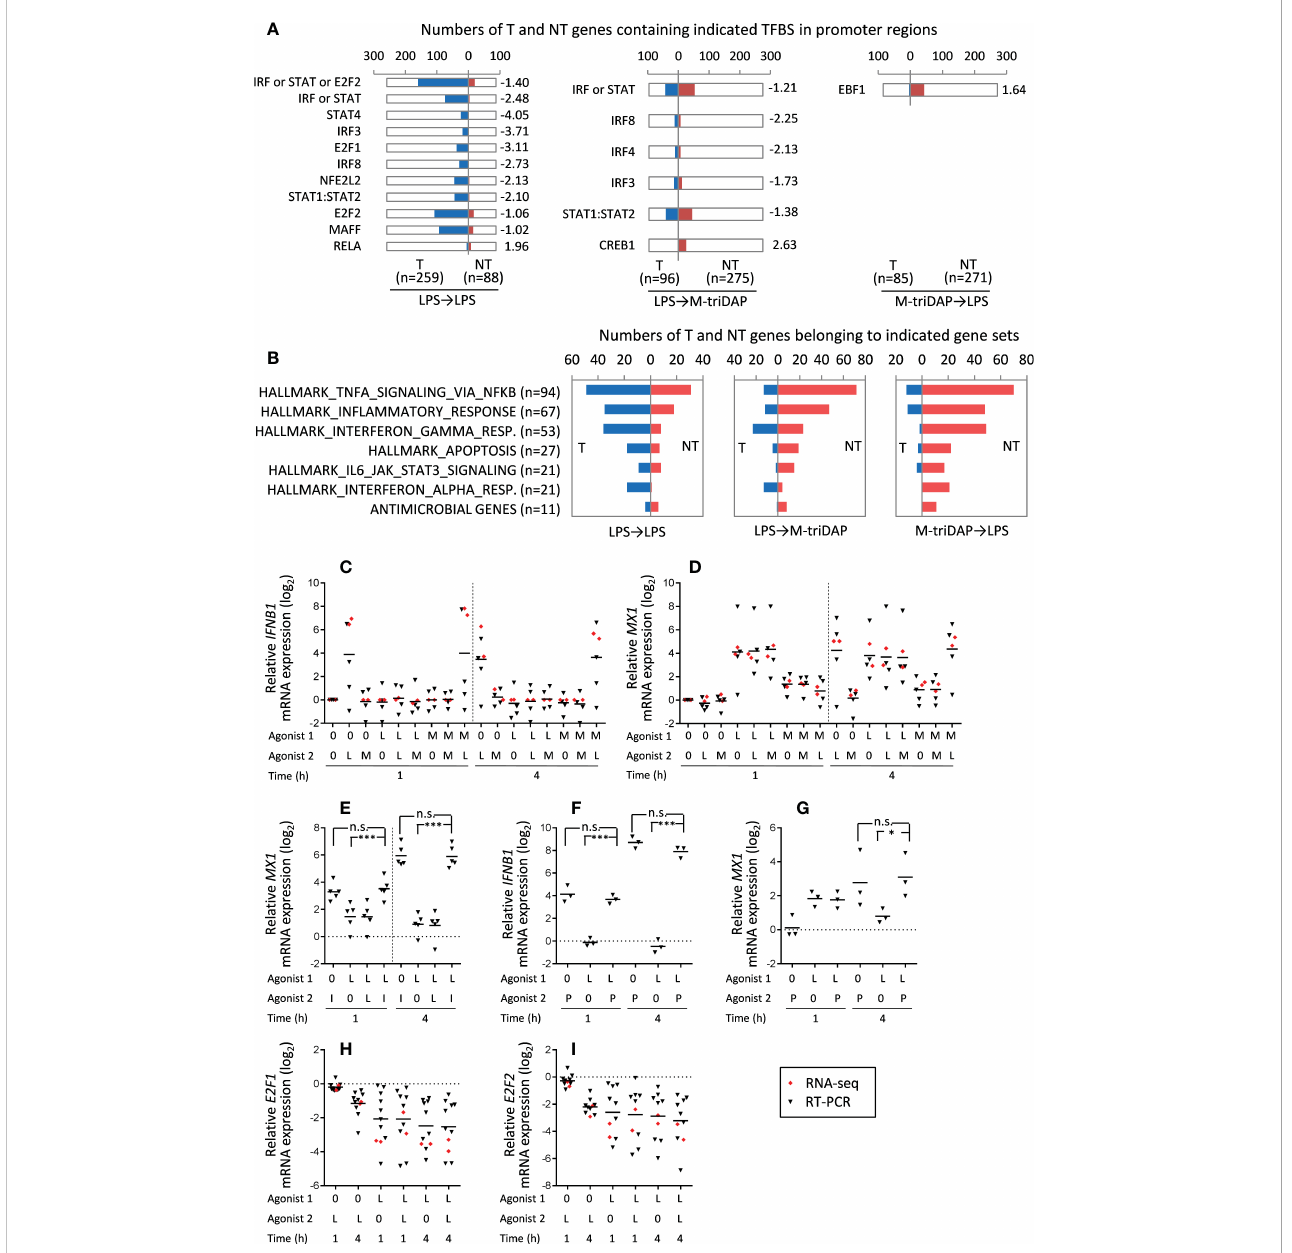
FIGURE 10 Regulation of T and NT gene expression in naïve and LPS-tolerized macrophages. (A) Numbers of T and NT genes containing indicated TFBS in their promoters. Only genes showing identical behavior in two RNA-seq experiments (see Figure 8A) are included in the analysis. Shown TFs satisfy following criteria: (i) TFBS are present in at least 10% of T or NT genes; (ii) enrichment score (ES) > 1; (iii) signi fi cant difference between frequencies of TFBS in T and NT gene sets (p < 0.01 by c 2 -test). Numbers to the right of the plots indicate ES. (B) Representation of genes from indicated gene sets among T and NT genes upon different stimulation sequences. (C, D) Relative expression of IFNB1 and MX1 mRNA, respectively, after different stimulation sequences at 1 and 4 h of 2 nd stimulation. Horizontal bars denote means. (E) Effect of exogenous IFN- b (I) on MX1 mRNA expression in naïve and LPS-tolerized macrophages. Cells were cultured for 24 h with medium (0) or with LPS (L, 100 ng/ml), then recultured for 1 or 4 h with medium, LPS (100 ng/ml) or rhIFN- b 1b (10 U/ml). (F, G) Effect of liposomal poly-I:C (P) on IFNB1 and MX1 mRNA expression, respectively, in naïve and LPS-tolerized macrophages. Naïve or LPS-tolerized macrophages were recultured for 1 or 4 h with medium (0) or liposomal poly-I:C (1 m g/ml). (H, I) Expression of E2F1 and E2F2 mRNA in naïve and LPS-tolerized macrophages recultured with medium (0) or LPS (L) for 1 or 4 h. In (C, D, H, I) , red and black symbols denote RNA-seq and RT-PCR data, respectively. *p < 0.05, ***p < 0.001, n.s. = non-signi fi